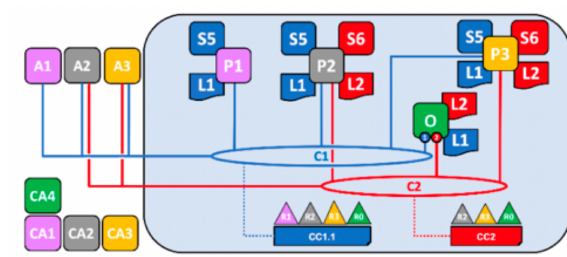
Figure 1. Hyperledger Fabric blockchain network